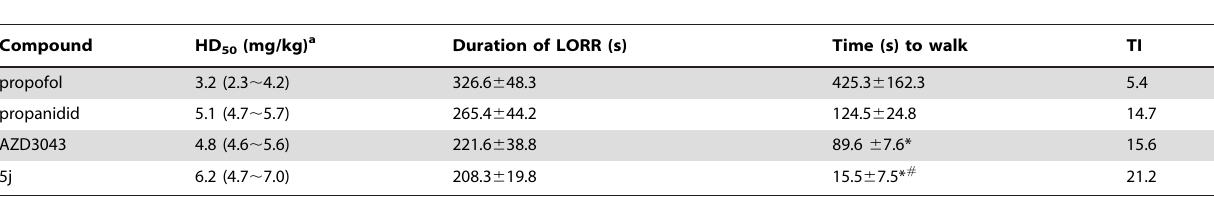
Table 3. Hypnotic potency of propofol, propanidid and 5j in rabbits.